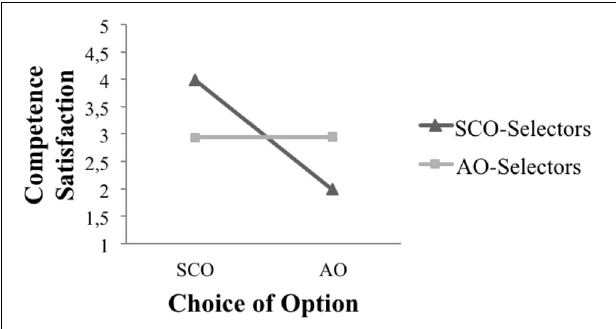
FIGURE 1 | Rating of competence satisfaction for the two